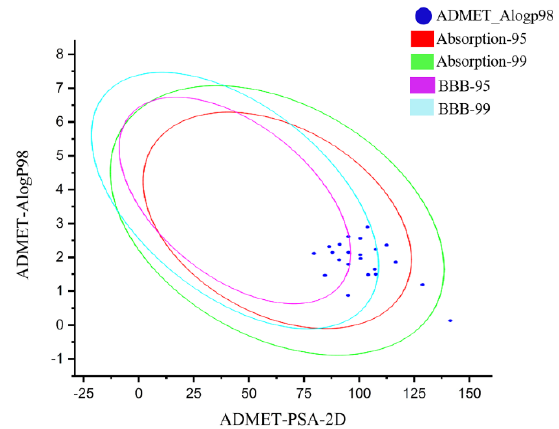
Figure 6. ADMET prediction for all designed compounds. Table 3. The ADME predictions of compounds. Comp.